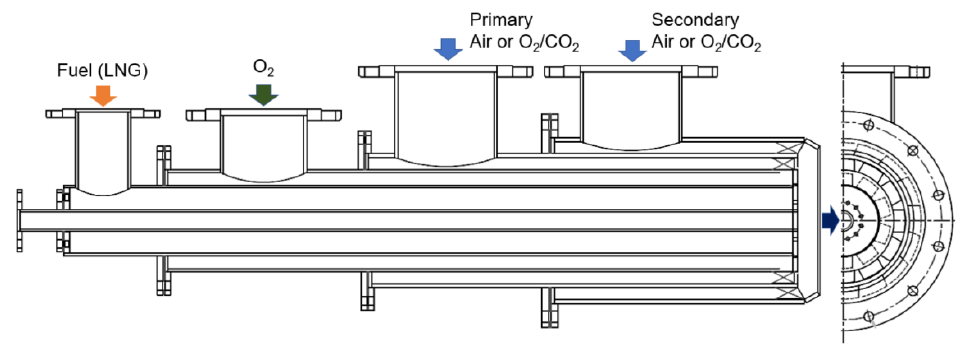
Figure 2. Oxy-fuel/air/FGR convertible burner.